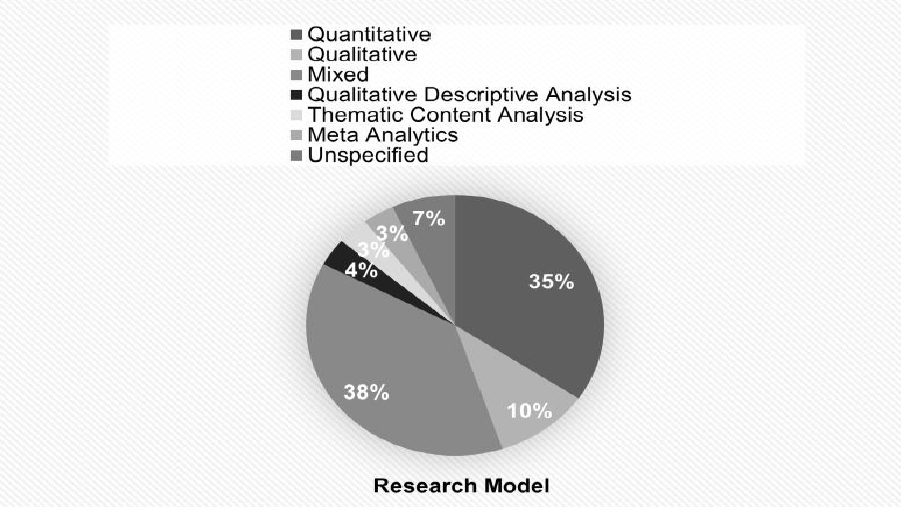
Figure 3: Distribution of Studies According to Research